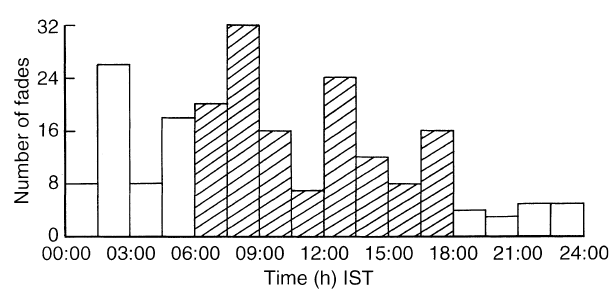
Fig. 2. Diurnal distribution of fades during daytime and night-time for eight storms; shaded region